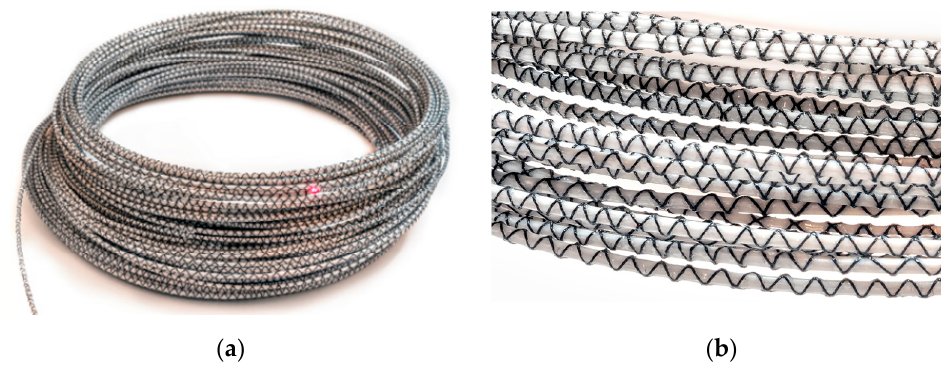
Figure 13. Example of flexible monolithic DFOS strain sensor : ( a ) general view; ( b ) close-up to the bi-directional outer braid.